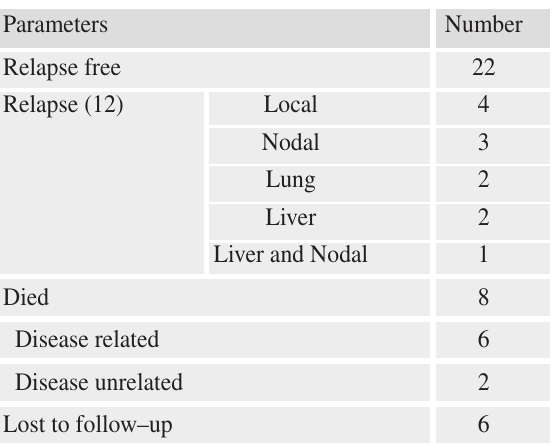
Table III: Survival data (3-year